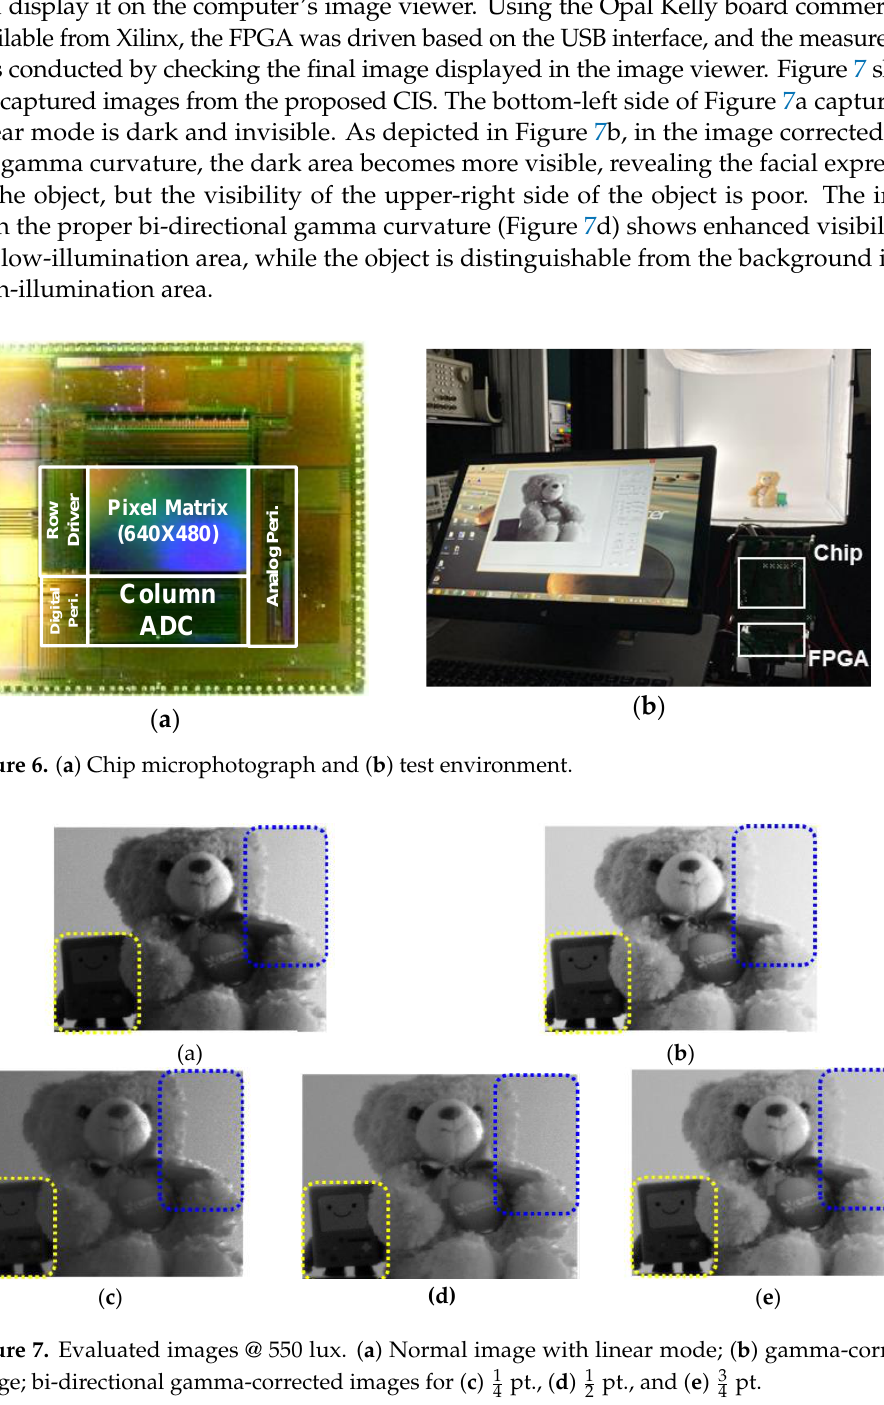
pt., ( d ) 1 pt., and ( e ) 3 2 4 4